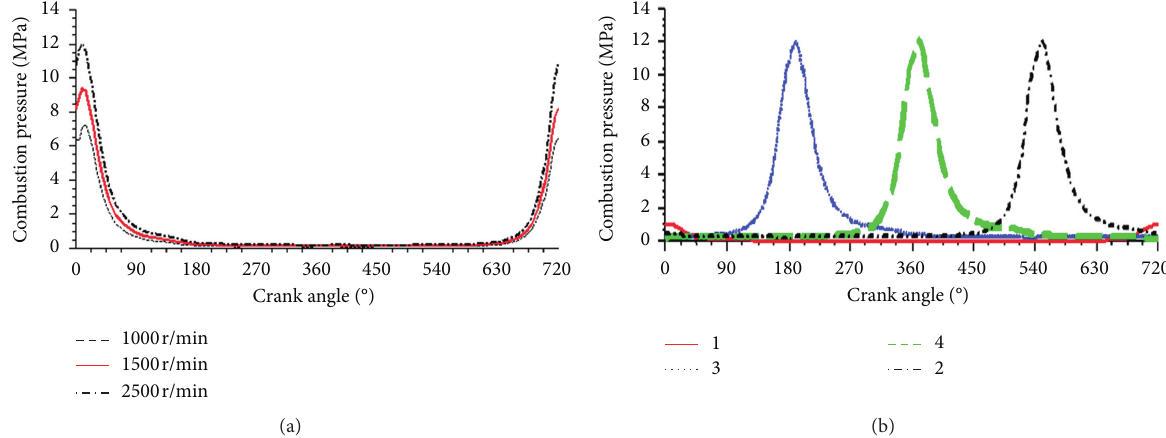
Figure 3: Combustion pressure variation along with crank angle. (a) Normal state. (b) First cylinder misfire fault in the four-cylinder engine model.